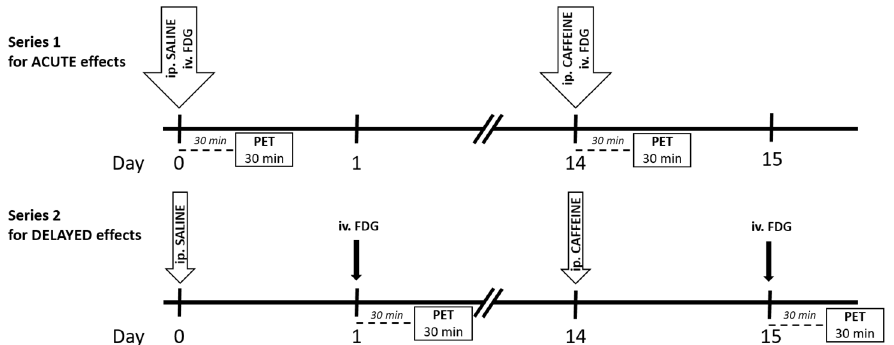
Figure 1. Time scale of the experimental paradigm for both series. Abbreviation: FDG: 18 F-FDG. The tracer was administered intravenously (iv.), and saline and caffeine were injected intraperitoneally (ip.). The PET was performed 30 min after tracer injection for 30 min.